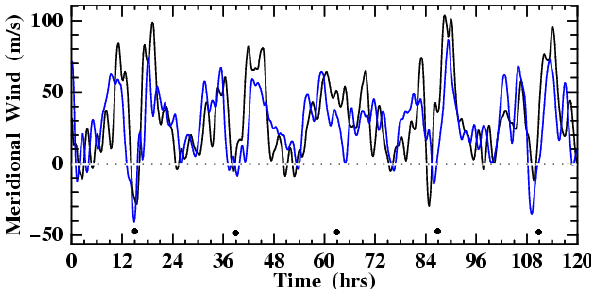
Fig. 10. Meridional wind variations at a constant-pressure surface ( ∼ 310km) during 1–5 December in the Northern (winter) Hemi- sphere at 141 ◦ E longitude and 14 ◦ N (blue line), and 2.8 ◦ N (black line) latitudes. The five circle dots in the panel indicate the times of midnight. Positive values indicate northward